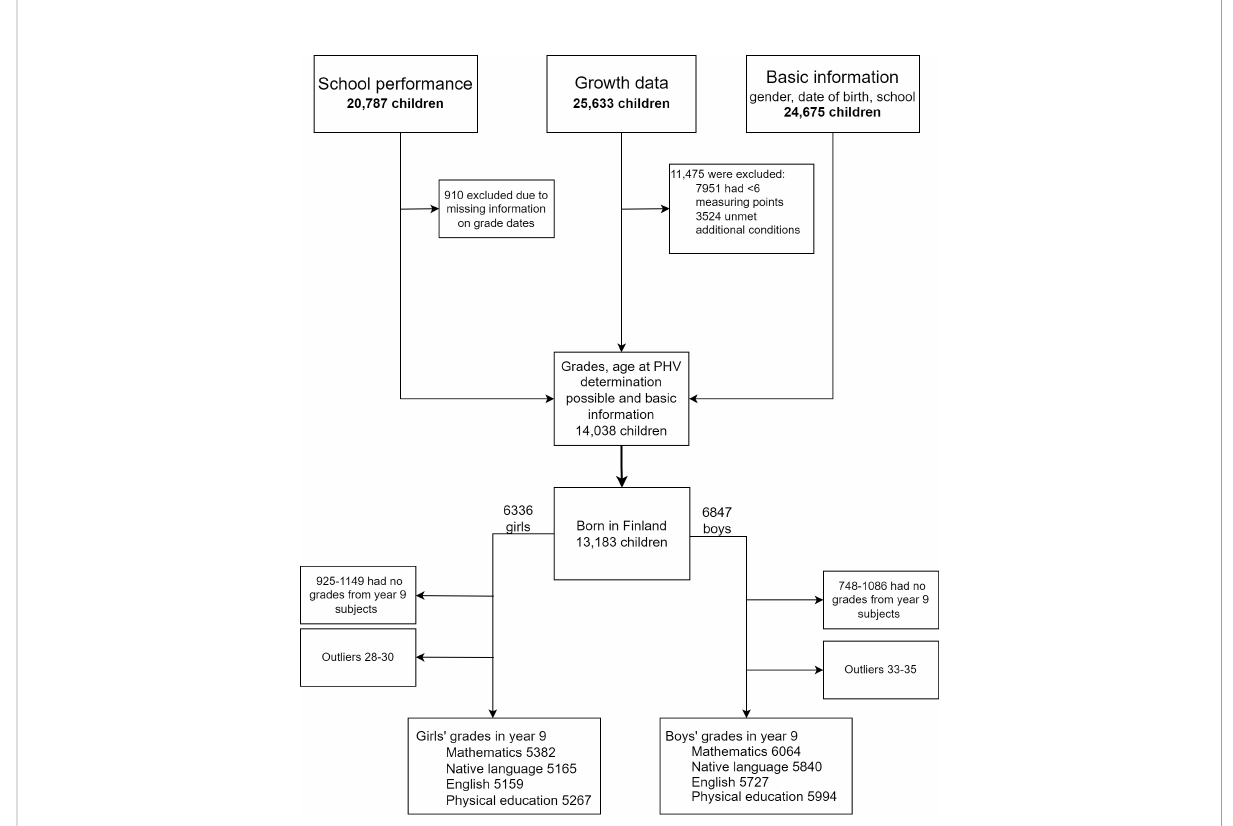
FIGURE 1 Study outline. School grades of children born between 1997 and 2002 were gathered from comprehensive schools in Espoo and integrated with growth and background